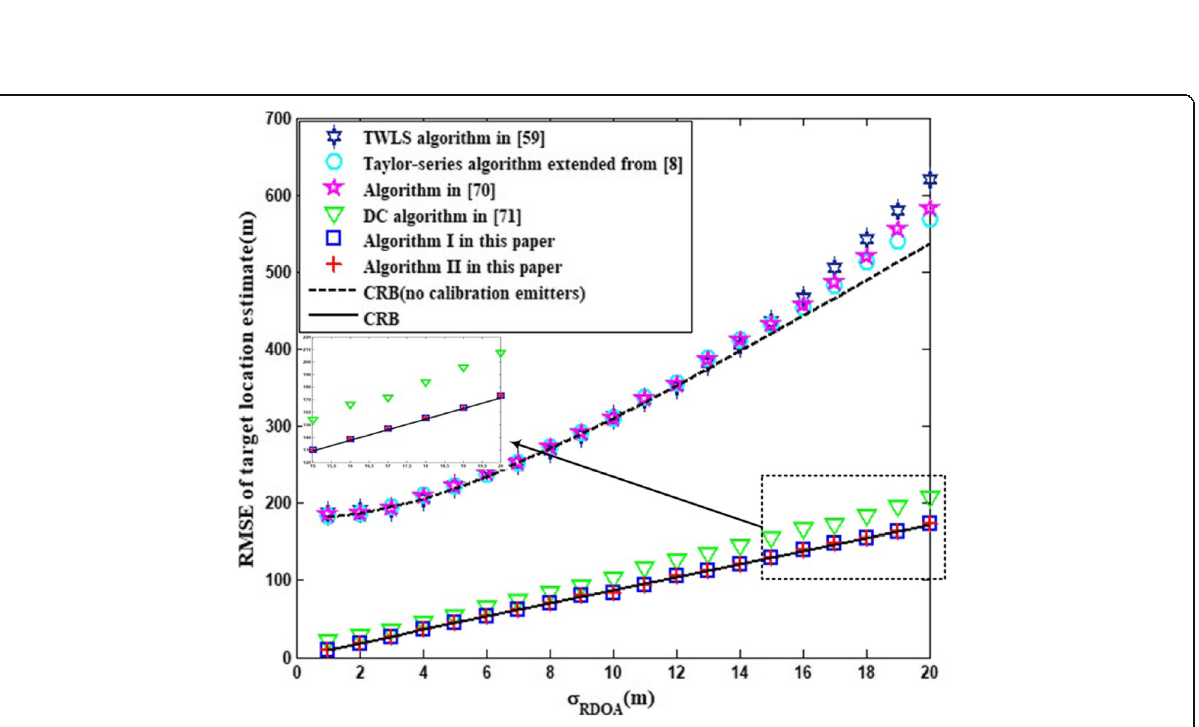
Fig. 6 RMSE of target location estimate versus σ RDOA